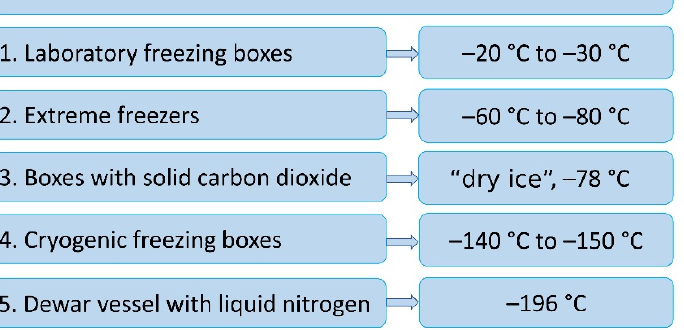
Figure 4. The five most common cryopreservation methods and the stated ideal temperatures inside the boxes in °C; data from Hubálek, 1996 [13]. the boxes in ◦ C; data from Hub á lek, 1996